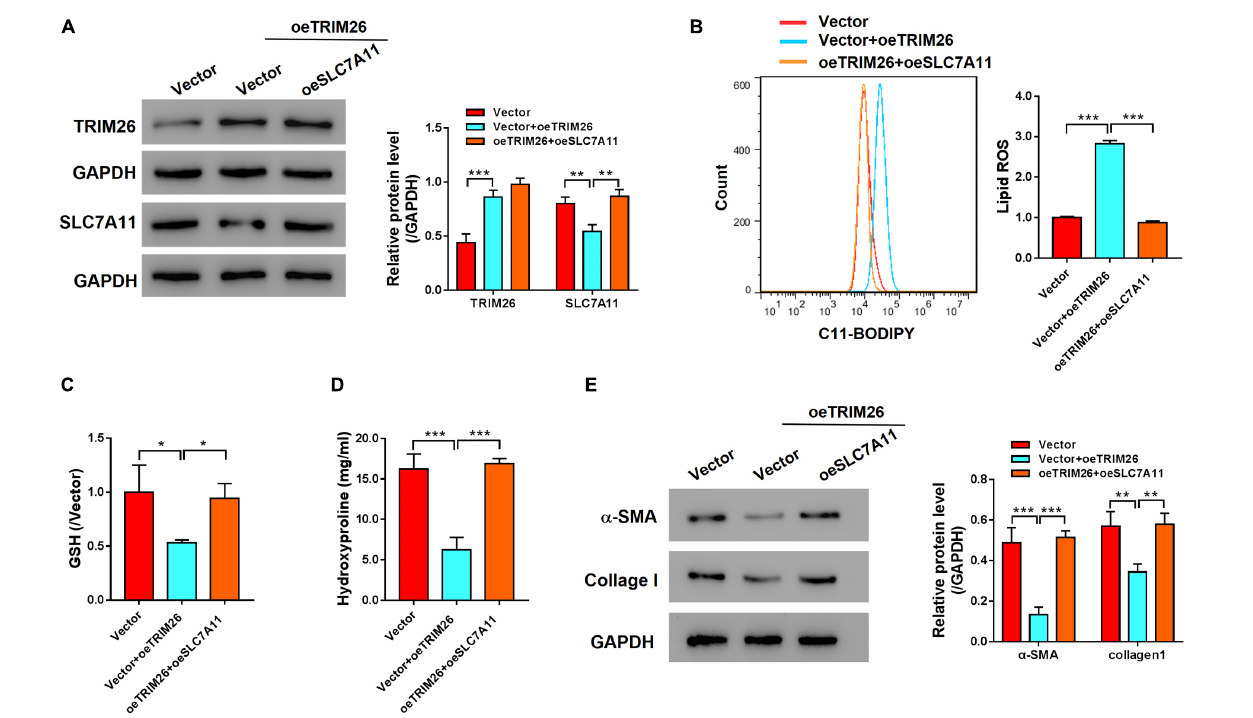
FIGURE 5 | SLC7A11-dependent mechanism of LX-2 ferroptosis. LX-2 cells were co-transfected with oe TRIM26 and oe SLC7A11 plasmids. (A) Protein expressions of TRIM26 and SLC7A11. (B) Lipid peroxidation level. (C) Glutathione content. (D) Hydroxyproline content. (E) Protein expressions of α -SMA and collagen I. * P < 0.05; ** p < 0.01; *** P <